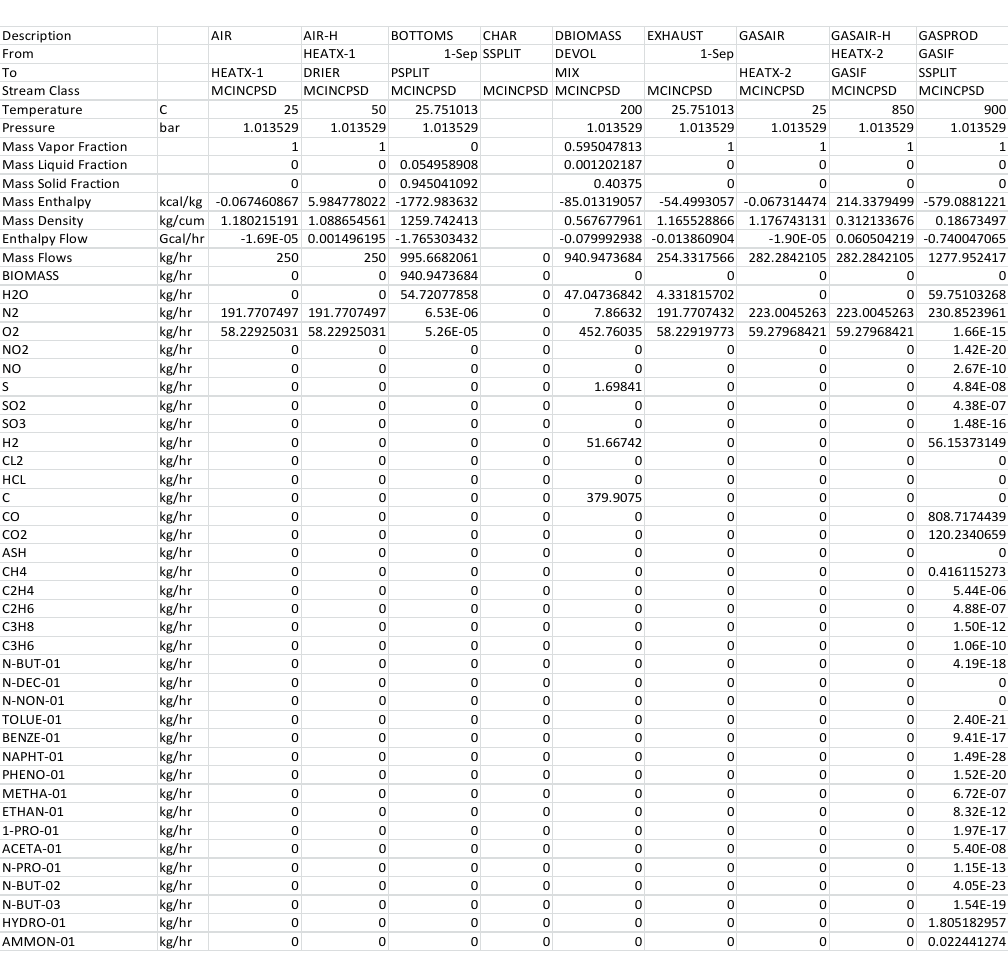
Figure A6. Gasification stream results (part 1).